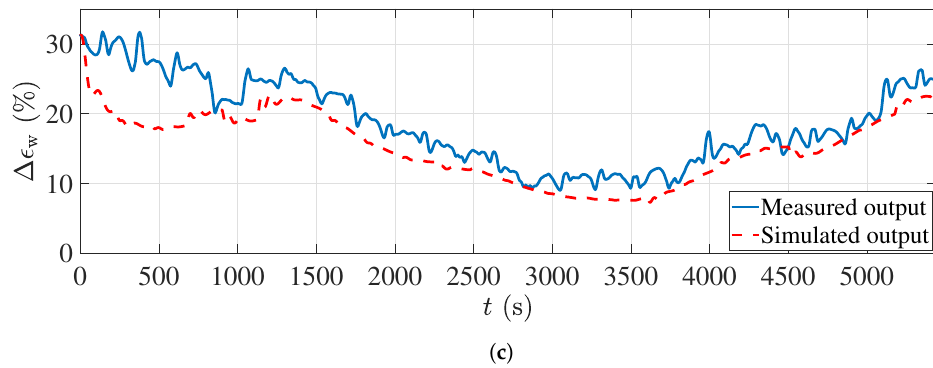
Figure 10. The input–output dataset with the staircase input signal used for validation of the process model: ( a ) The applied input power percentage to the microwave sources. ( b ) The input foam moisture variations. ( c ) Comparison between the actual measurements and the model output.